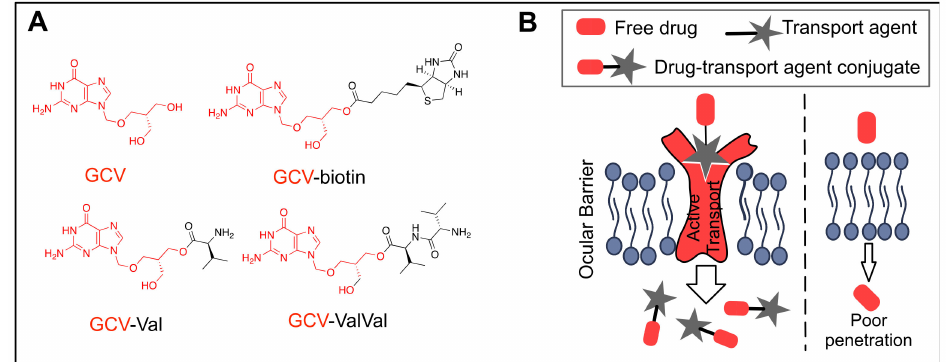
Figure 10. Drug conjugation with transport agents engaging in enhanced uptake via membrane transporters. ( A ) Ganciclovir (GCV), a polar and hydrophilic antiviral drug, is conjugated with biotin, di-valine (ValVal), mono-valine (Val) for active uptake. ( B ) Drug-transport agents conjugation enhances drug permeability by penetration through active